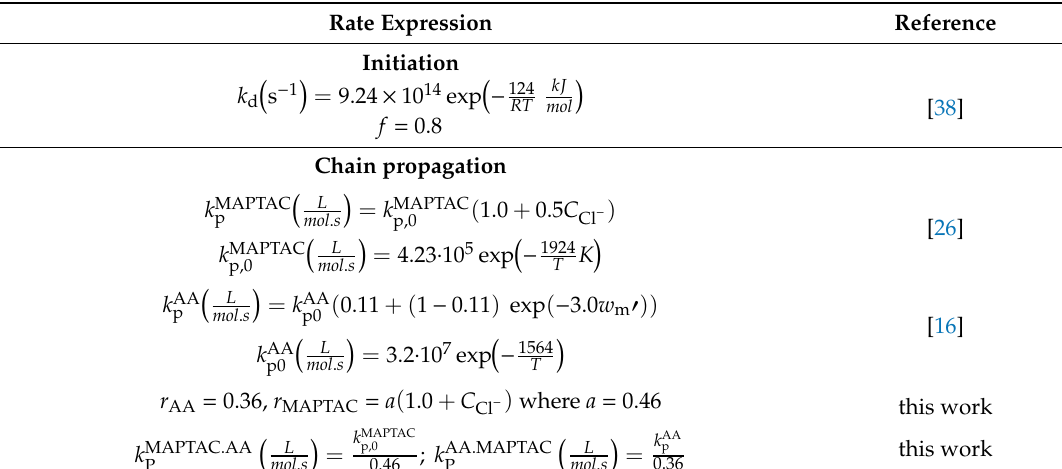
Table 2. Rate coe ffi cients and expressions used in AA-MAPTAC copolymerization